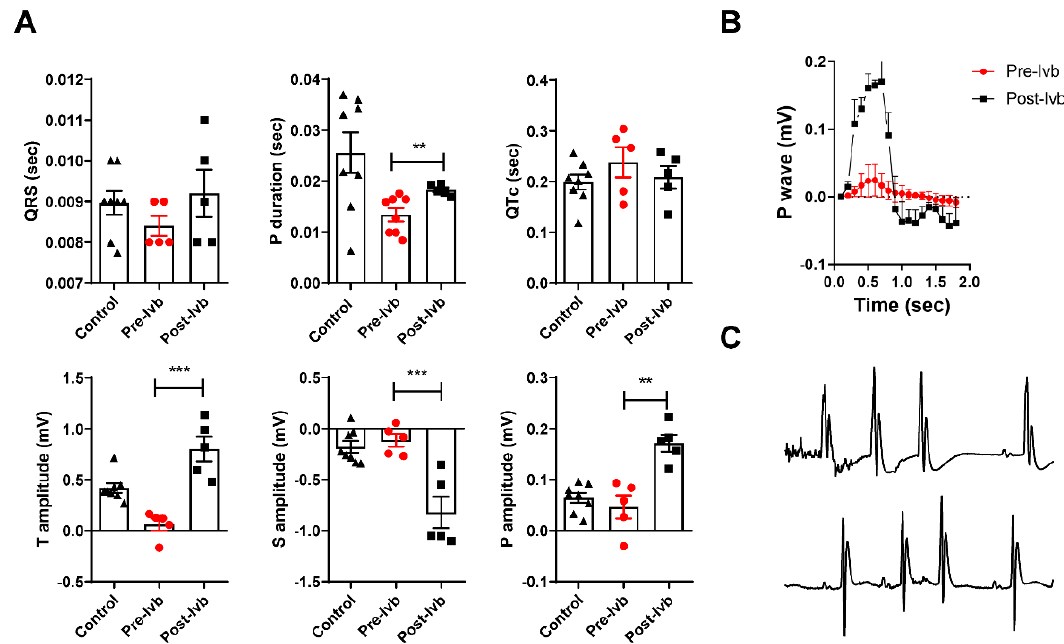
Figure 3. Quantitative/qualitative analysis of ECG parameters after continuous treatment with ivabradine (Ivb) in mice at the EA phase of infection. ( A ) Differences in wave voltages and amplitudes between treated (Post-Ivb) and untreated (Pre-Ivb) mice. Statistical significance was analyzed by one-way ANOVA (** p < 0.01 and *** p < 0.001). ( B ) Bimodal P-wave morphology, as seen in the mean P-wave trace. ( C ) Supraventricular ectopic beats were registered after continuous ivabradine treatment in chagasic mice.